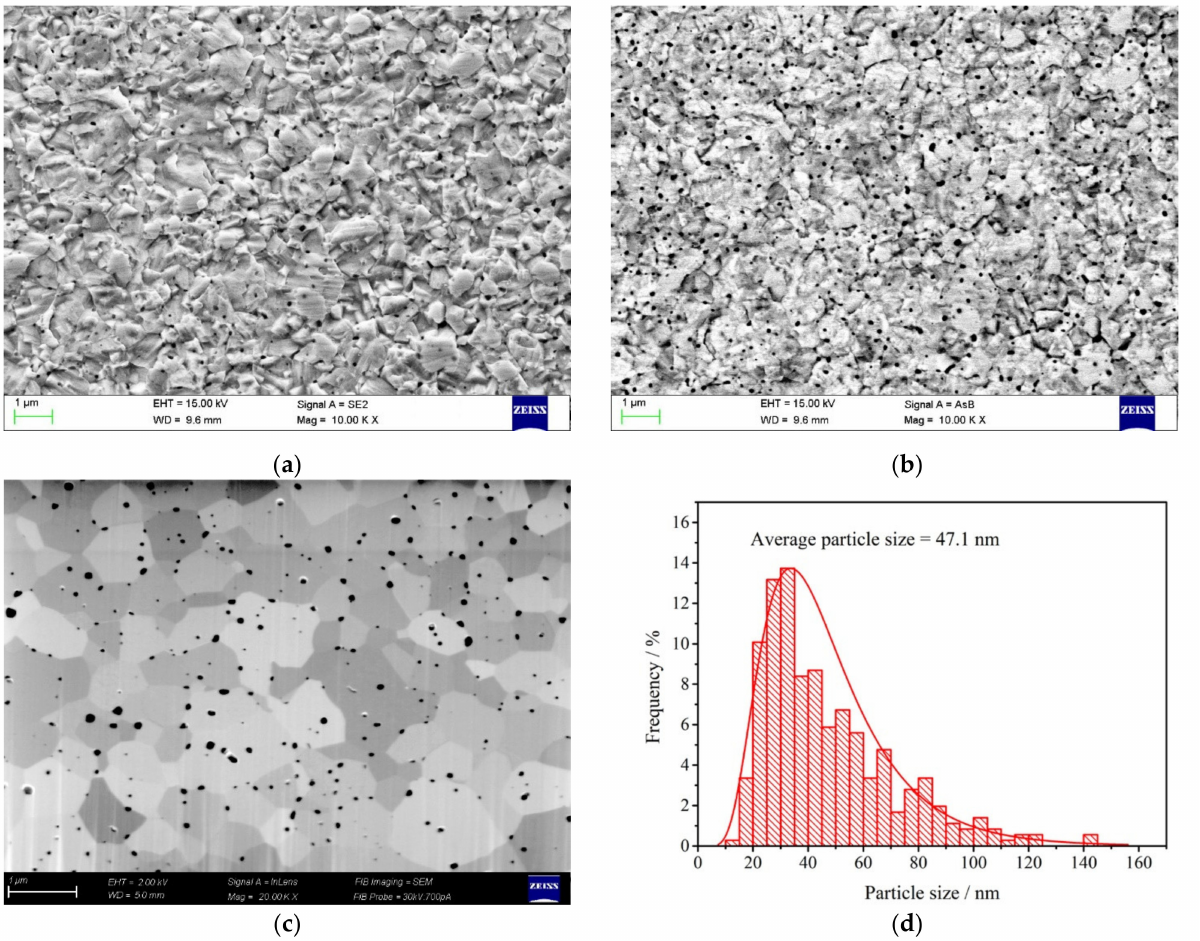
Figure 5. ( a , b ) FESEM images of the sintered W-TiC alloys acquired from the SE detector and the AsB detector, ( c ) FESEM images of the sintered W-TiC alloys after FIB polishing, and ( d ) particle size distribution of the TiC particles in ( c